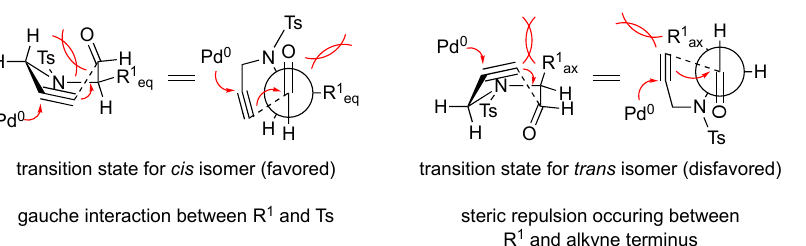
Figure 1. Diastereoselective cyclizations of 4b – e with a substituent at the α -position to the car- bonyl